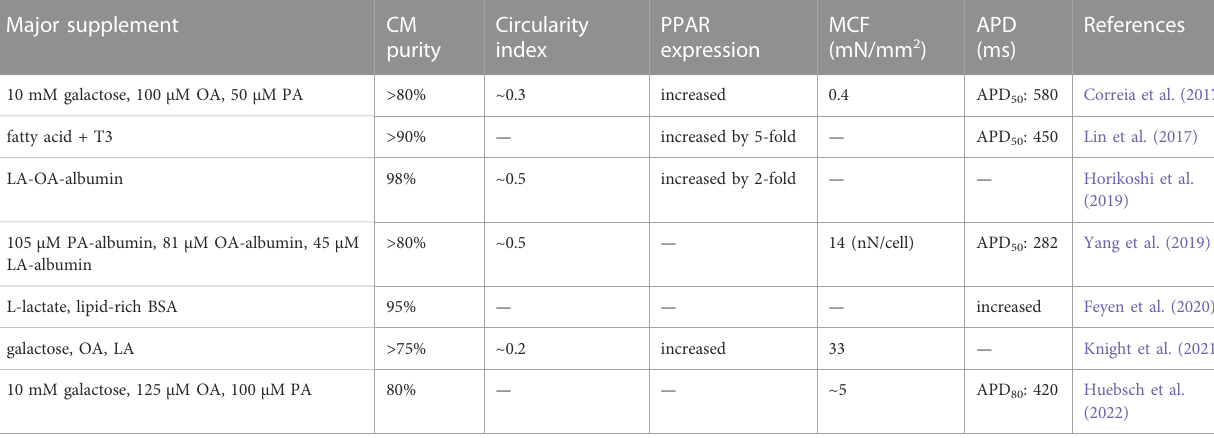
TABLE 3 The medium used for SC-CM maturation. Major